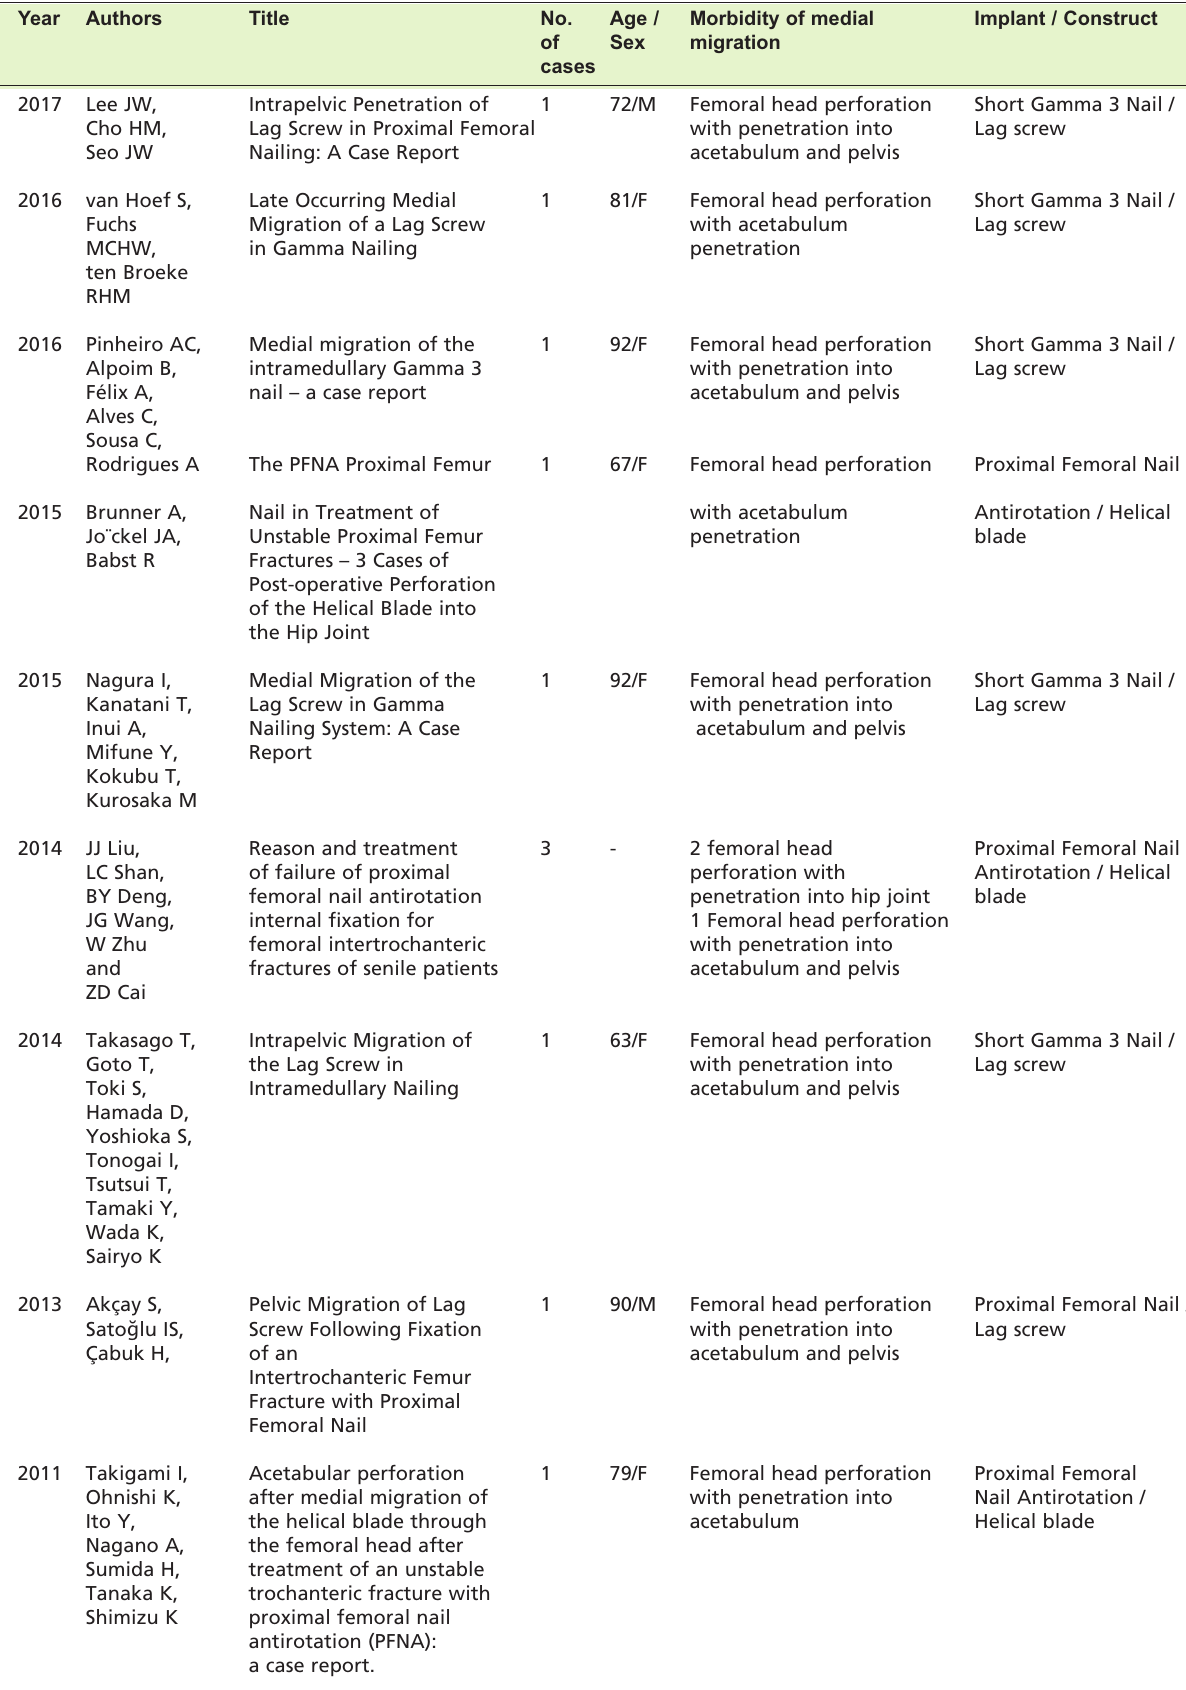
Literature on medial Table I: